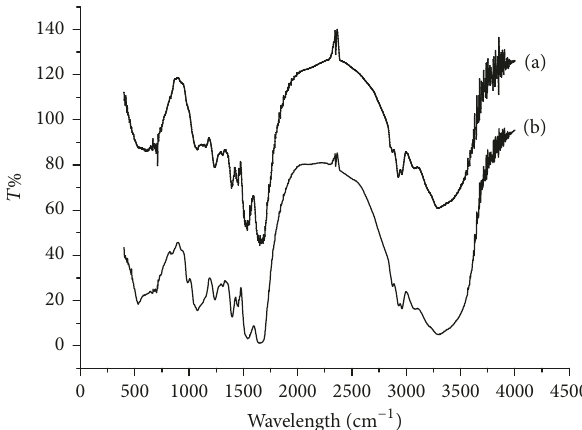
Figure 4: The FTIR spectra of SPI extracted by different extraction methods: (a) soybean protein isolate obtained using alkali-solution and acid-isolation method; (b) soybean protein isolate obtained using AOT reverse micelle extraction method.